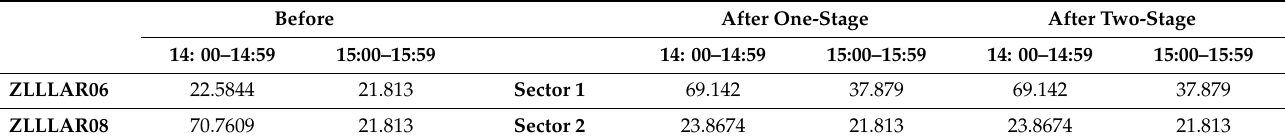
overloaded sectors are combined with their adjacent sectors as the target airspace, and the BSP algorithm is used to partition them in the first stage. After obtaining the initial partition lines by the one-stage BSP algorithm, the sector boundaries can be further optimized by the A*-based heuristic algorithm. Figure 10 shows Table 9. 14:00–15:59 Workload values for each sector before and after optimization. the relationship between the number of points connected to all sector partition lines and the weight values for all three time periods. As shown in Figure 10, with the increase of Before After One-Stage the weight  , the more the number of points connected by the partition lines, the more the waypoints and known entry/exit points within the sector are used. In this way, it is more convenient for the ATC to control the aircraft operation and improve efficiency. The smaller the weight value  , the smaller the number of points connected to the partition line, and the smoother the sector boundaries.